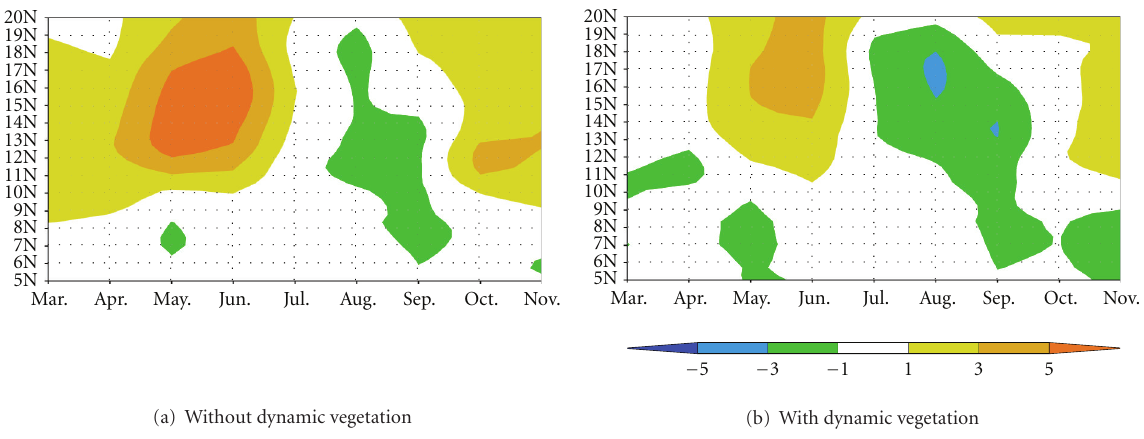
Figure 4: Changes in the troposphere stability between 1984–1993 and 2084–2093, averaged over 5 ◦ W-5 ◦ E, simulated without dynamic vegetation (a) and with dynamic vegetation (b). The troposphere stability is represented by the moist static energy di ff erence between 200mb and 850 mb (MSE 200 –MSE 850